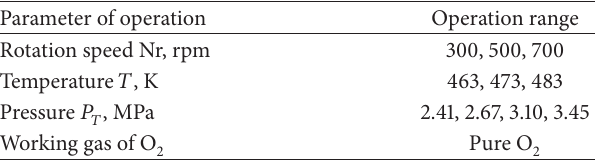
Table 1: Operation parameters and range of